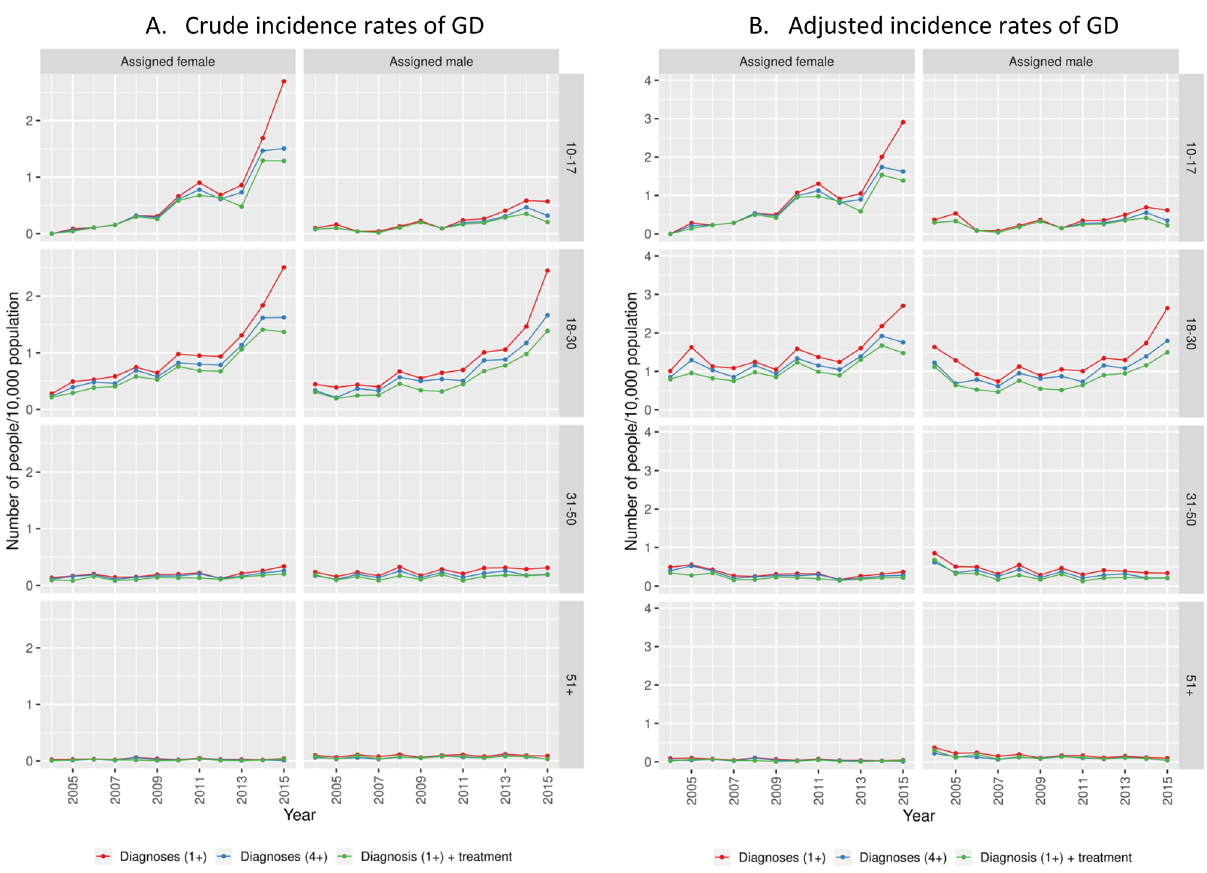
Figure 3. Crude ( A ) and coverage-adjusted ( B ) incidence rates of GD in Sweden 2004–2015, defined by ≥ 1 diagnosis, ≥ 4 diagnoses and ≥ 1 diagnosis with GCMI, stratified by birth-assigned sex and